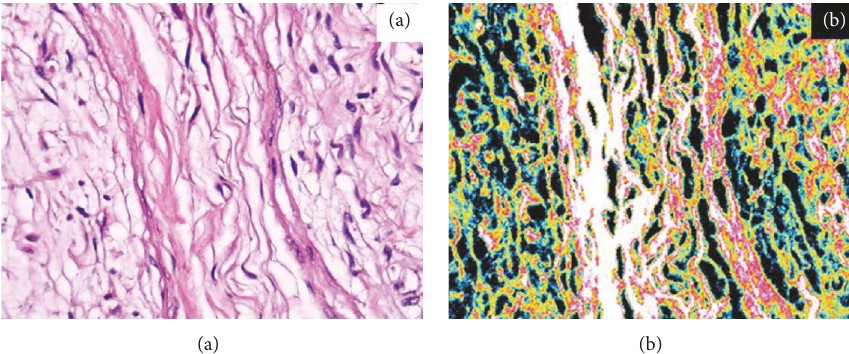
Figure 2: 150X. Traditional optical (a) and confocal laser scanning (b) analyses of a subcutaneous/nodular neurofibroma and its intense fluorescence due to the high content of neurofibromin in the well differentiated Shwann cells.